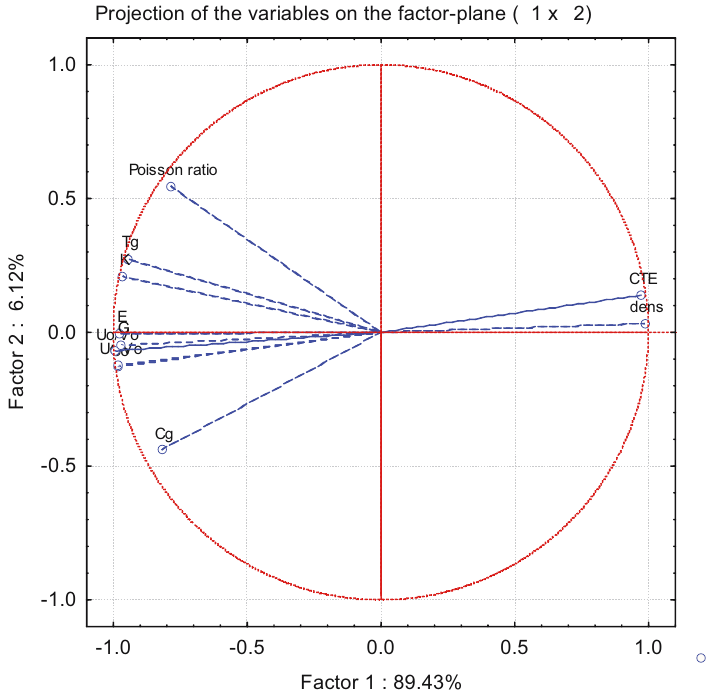
Figure 3: Projection of 11 variables on the plane described by factor 1 vs factor 2.